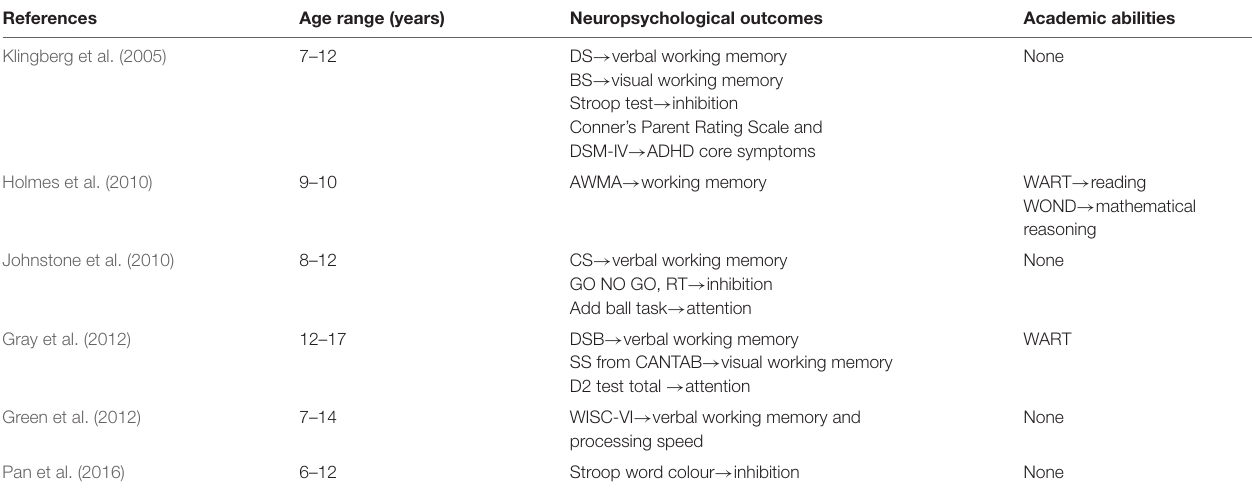
TABLE 2 | Examples of commonly investigated cognitive tests in